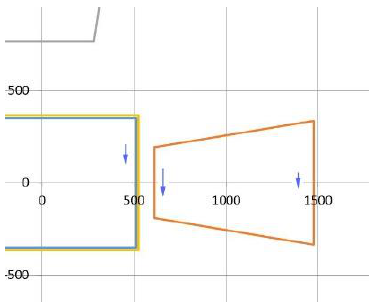
Figure 2a : Magnitude of Image Motion and corresponding motion blur at different image positions of nadir and oblique images: H_agl: 1065 m, GSD: 5 cm, SOG 50 m/sec, Tv = 2 msec, Image motion Nadir 7,5 µm eq. 2,0 Pixel, Oblique near 10,3 µm eq. 2,76 Pixel, Oblique far 5,9 µm eq. 1,58 Pixel The magnitude of the angular motion blur depends on the Figure 1a: UltraCam Osprey 4.1, nadir and oblique camera situation in the air, turbulences may happen and cause larger system by Vexcel Imaging GmbH, Graz, Austria. The camera movements of the camera, which could not be compensated by offers a 280 MPix mapping grade nadir component and four an active mount. Taking a roll angular rate in consideration, this 150 MPix oblique camera heads. causes a motion blur perpendicular to the flight line. The magnitude is angular rate multiplied by focal distance and exposure time (e.g. tan 5° per second multiplied by 80 mm focal length and by 2 msec exposure time leads to 14 µm image